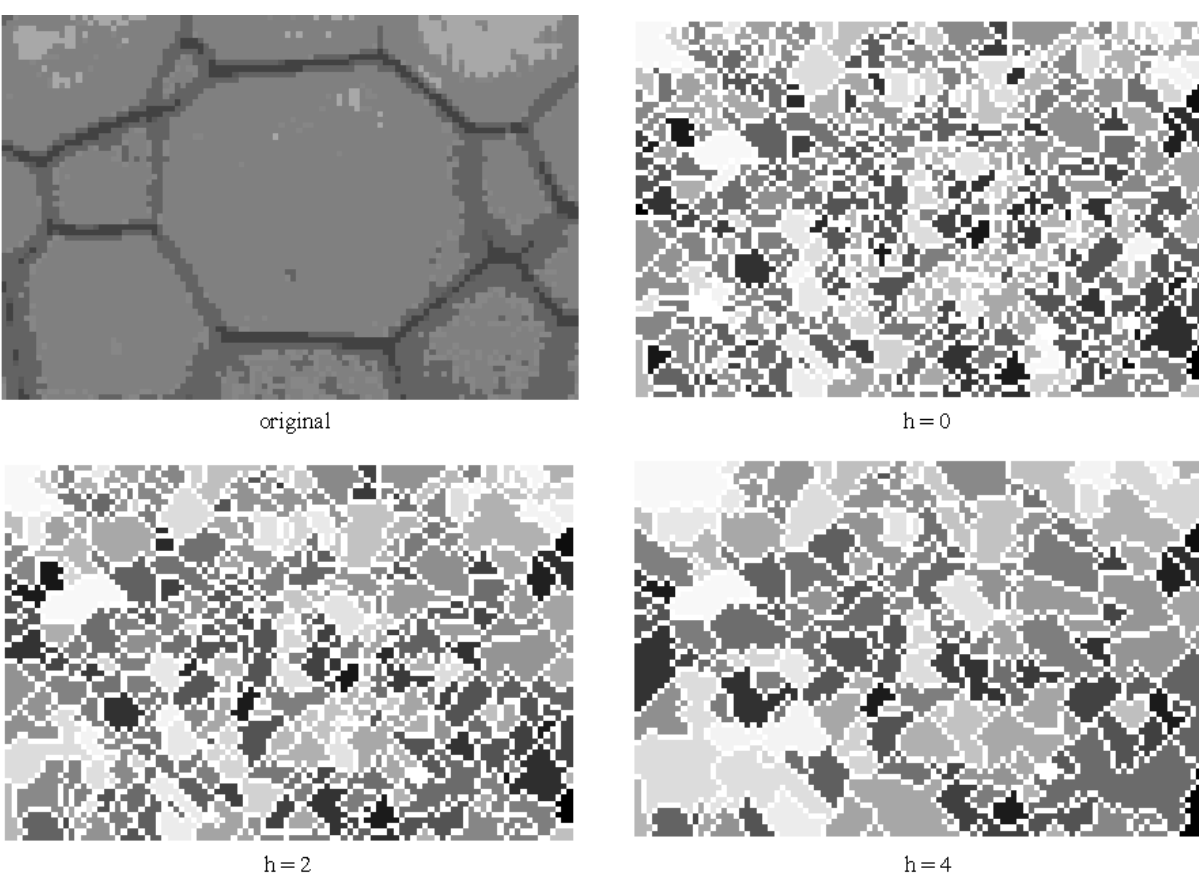
Figure 6. Time sequence absorptions for different h values (depth) during flooding with